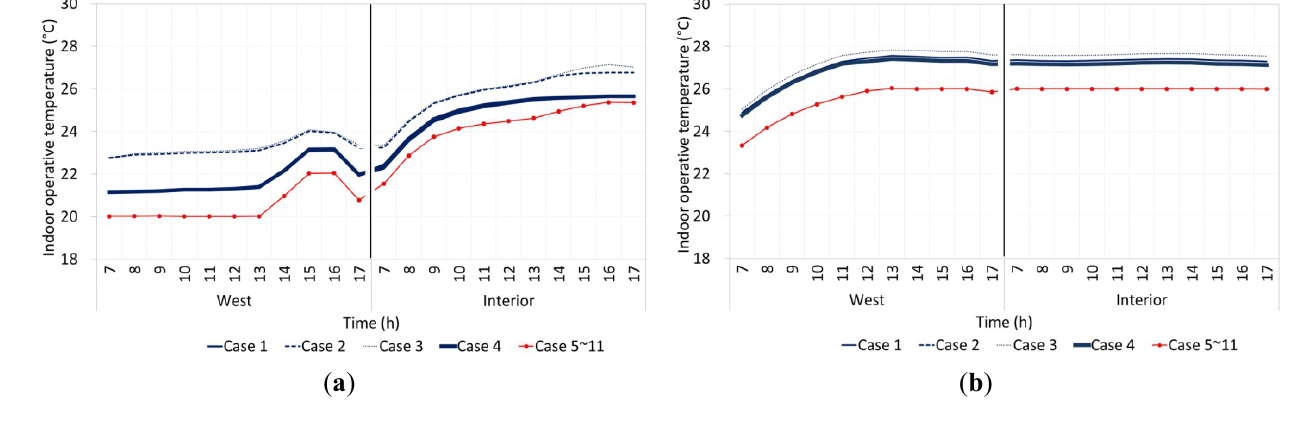
Figure 4. Indoor operative temperature (Middle floor): ( a ) winter (14 January); ( b ) summer (12 August). Note: ( a ) Cases 1 and 4 have similar temperature profiles and therefore are printed one over the other; ( b ) Cases 1, 2 and 4 have similar temperature profiles and therefore are printed one over the